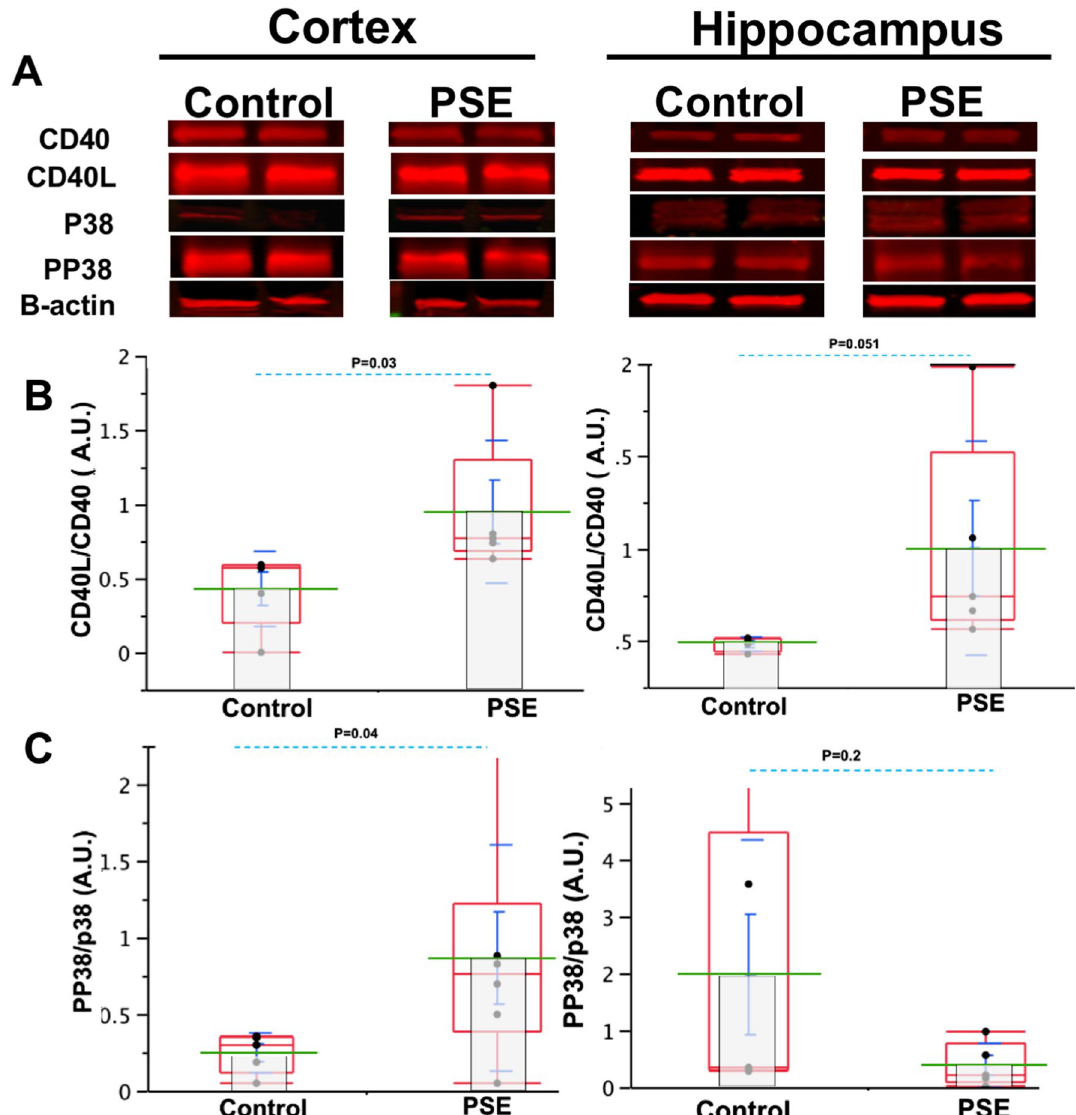
Figure 3. PP38/P38 and CD40–CD40L increases after status epilepticus. ( A ) Representation of bands from respective hippocampus and cortex gels ( B ) CD40L/CD40 expression in the cortex is higher in PSE (n = 5) than control (n = 5) ( p = 0.03) showing a trend to increase in hippocampus ( p = 0.051) respectively. ( C ) PP38/P38 expression in the cortex ( p = 0.04) is higher in PSE than control and non-significant differences between groups are present in hippocampus ( p = 0.2). Data in graphics show individual values (black dots), mean (green line); standard error mean (S.E.M., blue bar), Standard deviation (blue line) and quartile (red